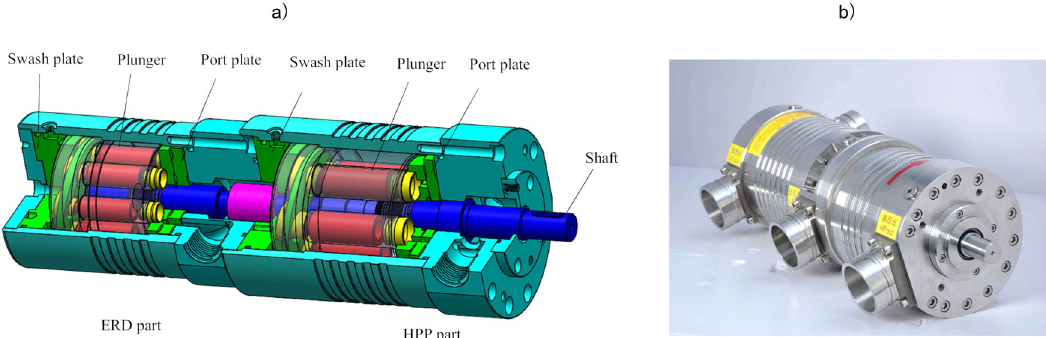
Fig. 4 Portrayal of the HPP-ERD. a Structure diagram (reprinted from ref. 46 , with permission from Elsevier) shows that the proposed HPP-ERD is mainly composed of swash plates, plungers, port plates, and one shaft. b The actual appearance of the proposed HPP-ERD prototype is given in the photograph.